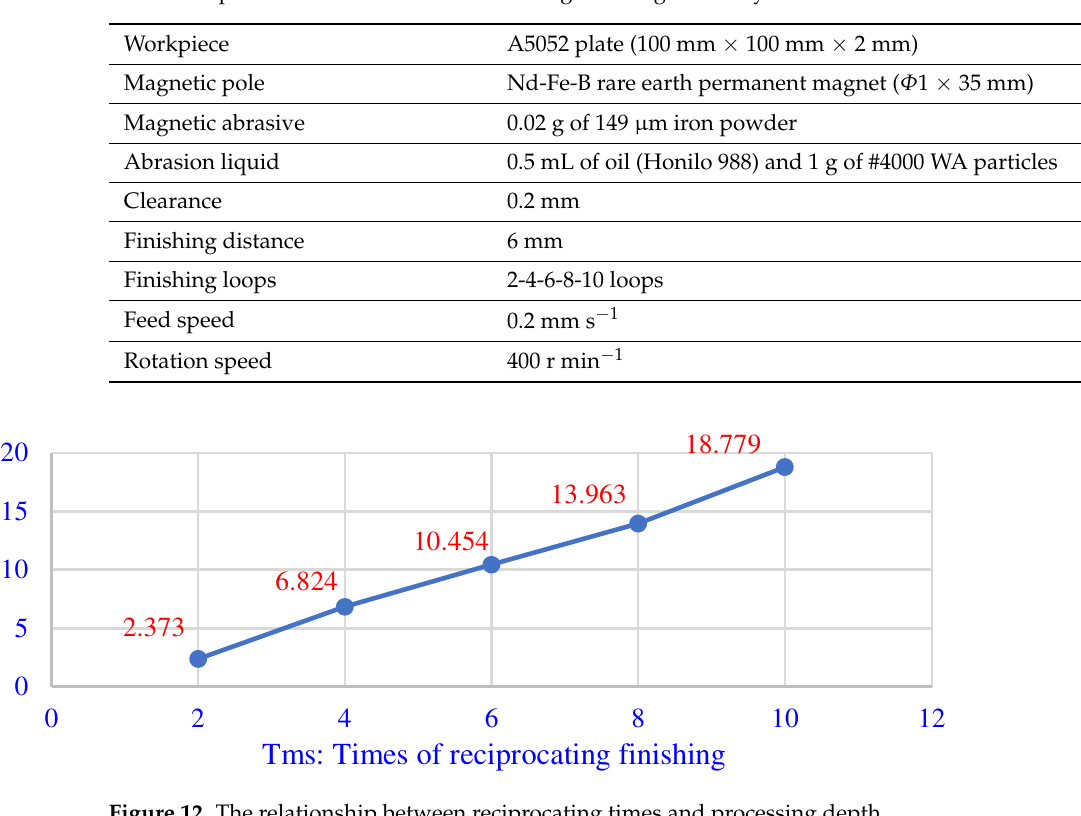
Table 2. Experimental conditions of preparation finishing.